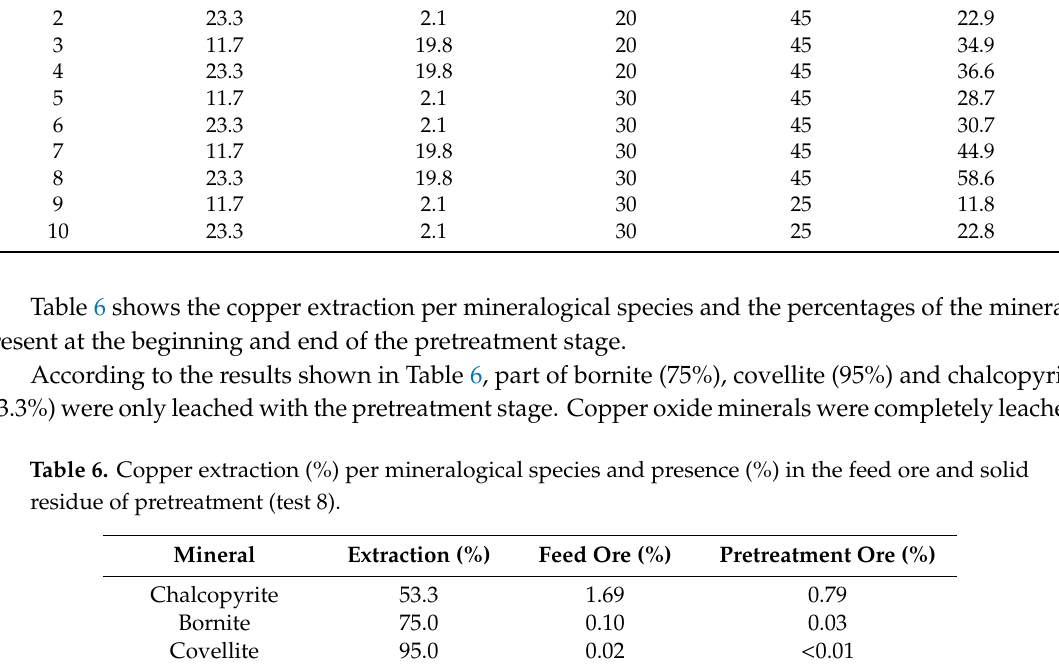
Table 6. Copper extraction (%) per mineralogical species and presence (%) in the feed ore and solid residue of pretreatment (test 8).